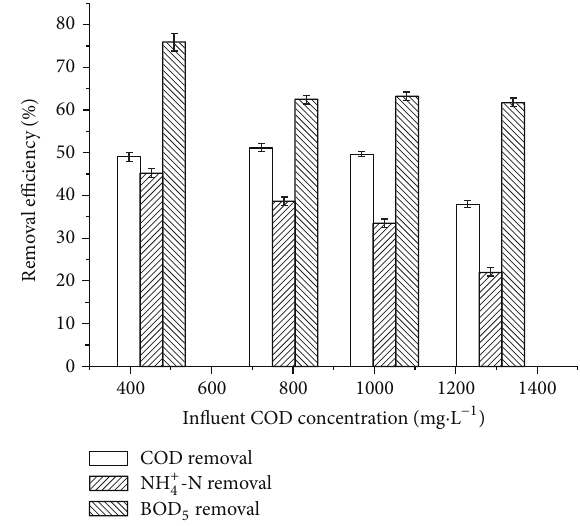
Figure 3: Effect of influent concentration on the COD, NH + 4 -N, and BOD 5 removal and their standard